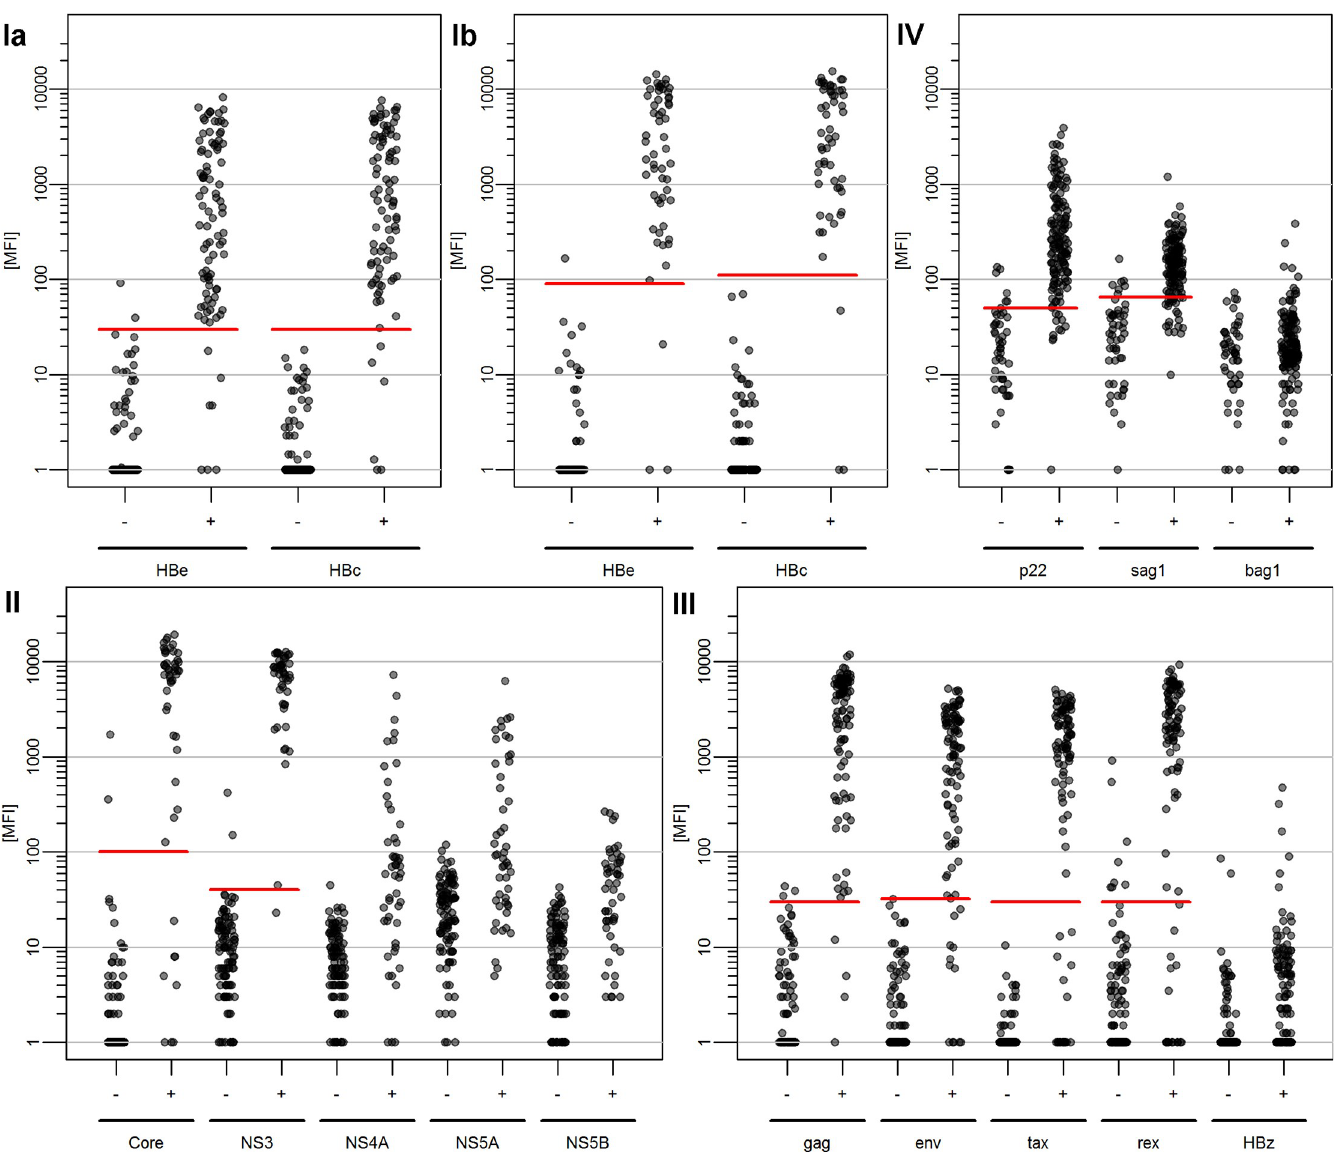
Fig 1. Comparison of quantitative antibody measurements (MFI) with reference serostatus in pathogen-specific Monoplex Serology for HBV (Ia, Ib), HCV (II), HTLV-1 (III) and T . gondii (IV). Ia, Ib, II-IV indicate corresponding reference panels. red lines: optimized cut-offs for single antigen performance; cut-offs were determined by optimizing specificity and sensitivity analogous to Receiver Operator Characteristics analysis. No cut-offs were determined for antigens that showed a reduced capacity to distinguish between reference assay positives and negatives. MFI: Median Fluorescence Intensities.